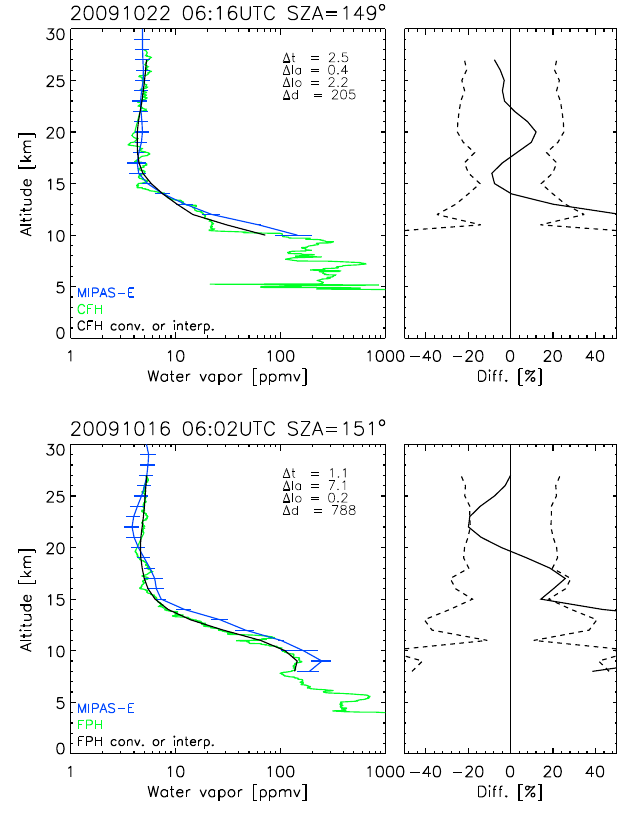
Fig. 10. Same as Fig. 8 but for CFH (v3.20, top row) and NOAA FPH (bottom row) frost point hygrometer profiles of water vapor. For a more detailed description see Fig. 8.